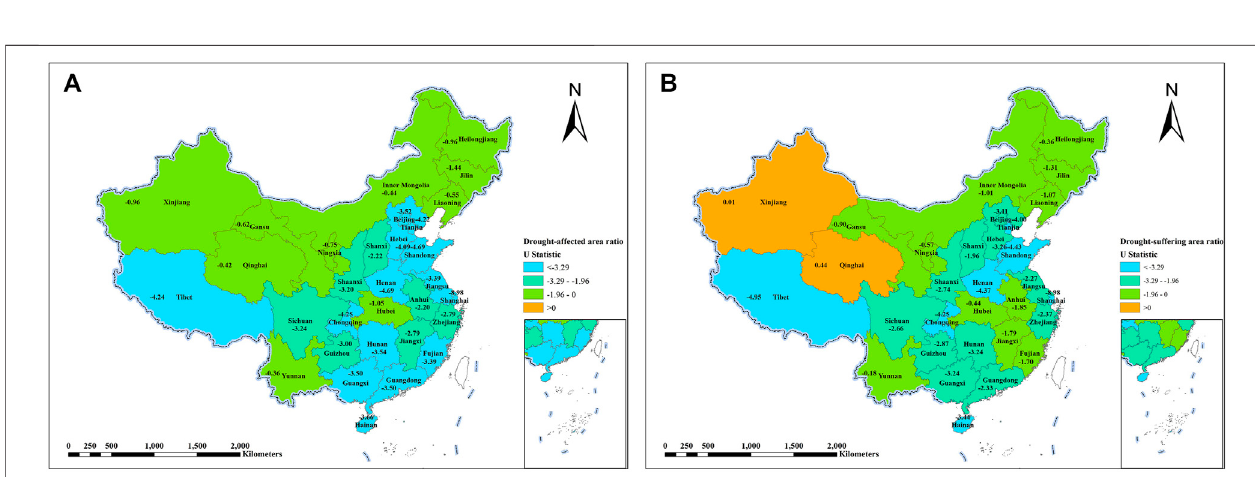
FIGURE5| Spatialdistributionof U statisticderivedfromMann – Kendalltestofagriculturaldroughtdisasters. (A) Drought-affected arearate. (B) Drought-suffering area rate.